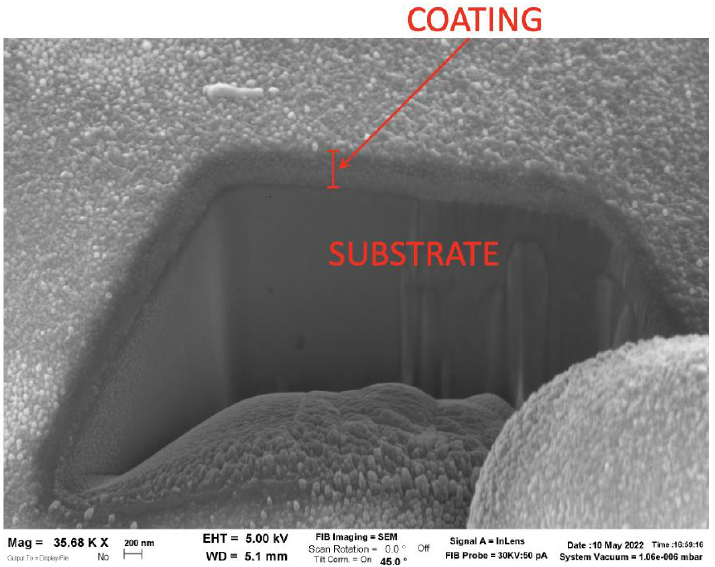
Figure 14. SEM images at ( a ) 2000×, ( b ) 10,000×, and ( c ) 40,000× of surfaces obtained with parallel lines scanning strategy at 12 W: Surf 4 sample (laser texturing + PE-CVD).